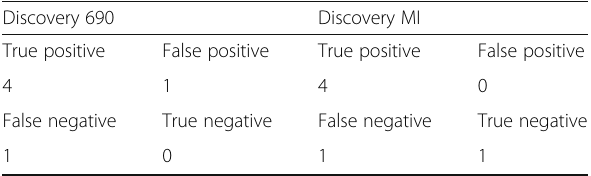
Table 6 Lymph node — histology compared to metabolic